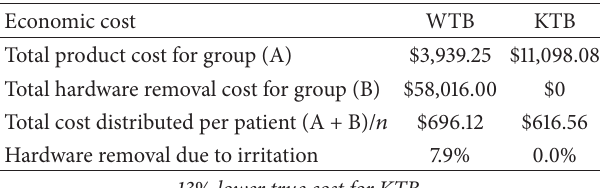
Table 4: Details concerning economic costs based on data from our